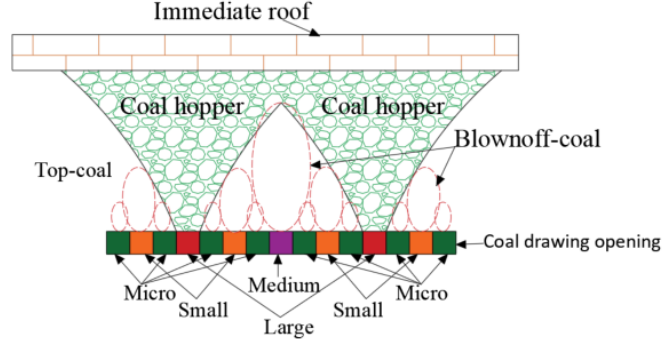
Figure 3. Mining technology of working face.